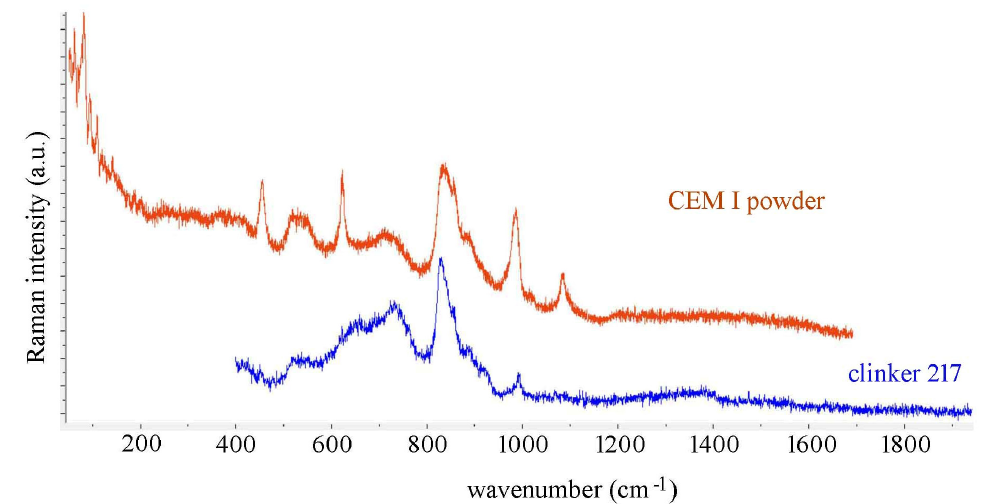
Figure 3. Comparison of Raman spectra of CEM I powder (clinker 217 with few percent of gypsum) and clinker 217.